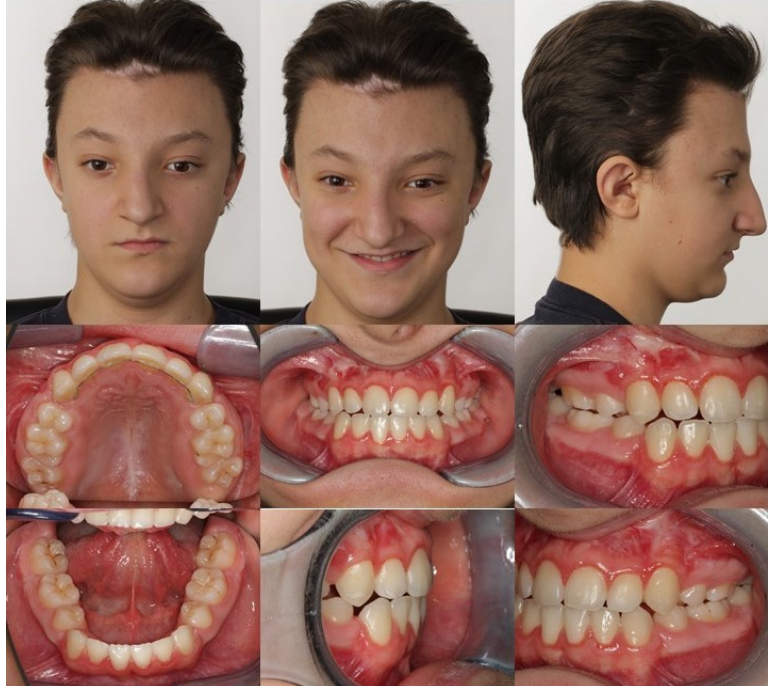
Figure 5. Stable treatment result at the end of the orthodontic retention period at the age of 15. A slight relapse of the skeletal (and thus also dental) relationship due to permanent growth inhibition in the midface region cannot be ruled out until definitive growth completion.